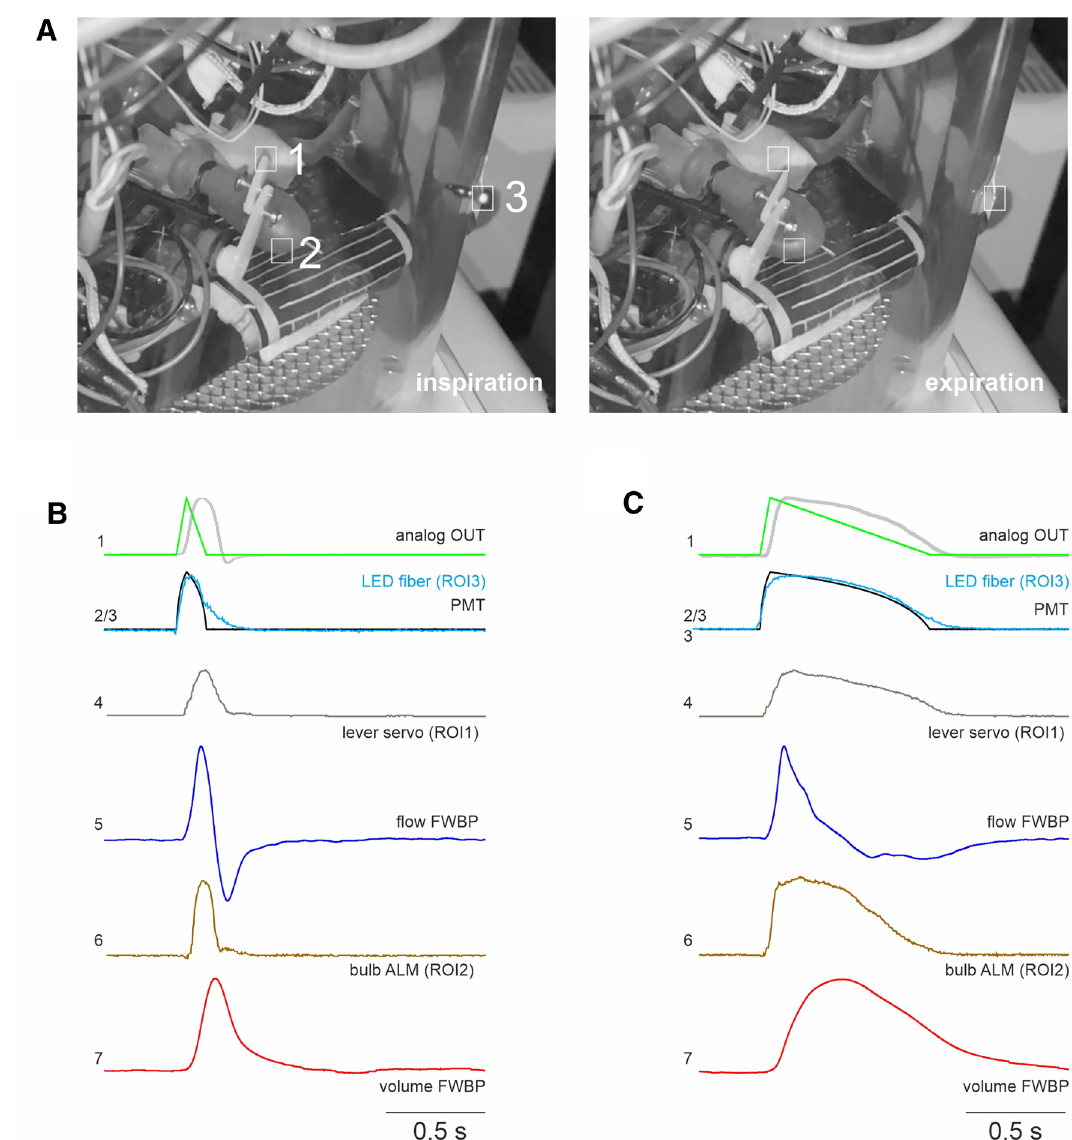
Figure 4. Flow whole-body plethysmography (FWBP) of the artificial lung model (ALM). ( A ) Two frames; inspiration (left) and expiration (right) from a video of the ALM during the FWBP taken at 240 Hz. Regions of interest (ROIs) were placed on the servo motor lever of the ALM (ROI1), on the bulb of the ALM (ROI2) and on the tip a light guide that allowed the synchronization with the plethysmography measurement (ROI3). ( B ) Timing of different parameters of the ALM with 50 ms duration of the inspiration (T I ) and 100 ms expiration (T E ). (1) Green trace analog out from the digitizer. The gray trace represents the inverted pressure measured in the bulb according to the measurement shown in Fig. 1. (2) PMT signal of the LED (3) that was driven from the analog out and was also the source for the light signal that was recorded by the video. Graphical overlay of the two signals allows exact matching of the signals from the video and the A/D interface (4) Intensity of the ROI1 from the servo motor lever indicating the response of the ALM. (5) Flow signal of the FWBP. (6) Intensity of the reflex from the bulb of the ALM. (7) Volume of the FWBP. ( C ) Timing of the FWBP-parameters (see B ) from ALM recording with a T I of 50 ms and a T E of 800 ms. Traces are averages of at least 3 consecutive